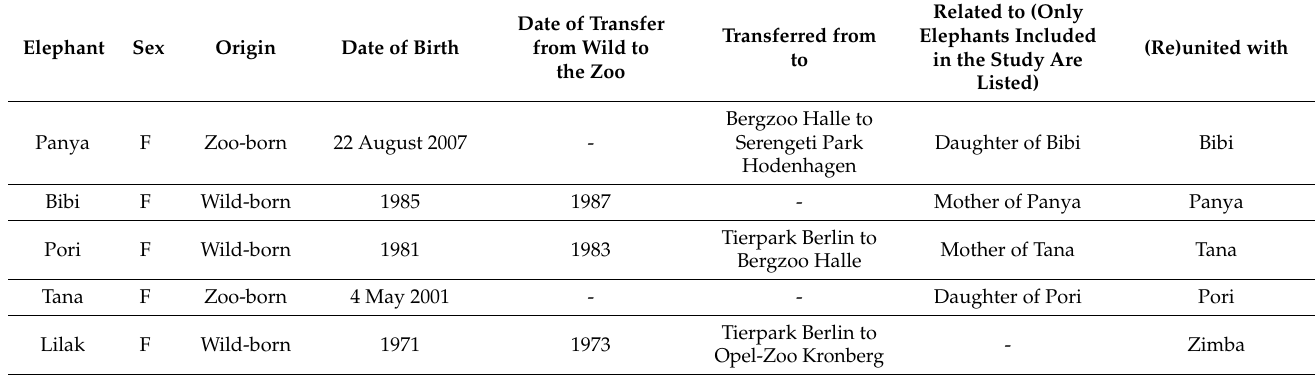
Table 3. List of